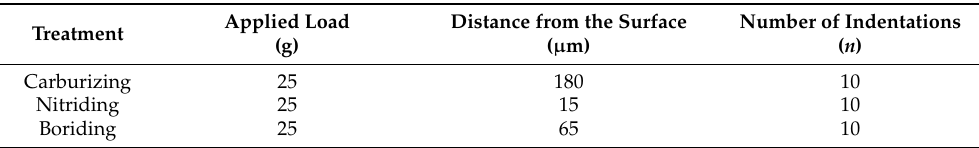
Table 3. Applied load and distance from the surface to evaluate the hardness for the different surface-hardening processes.